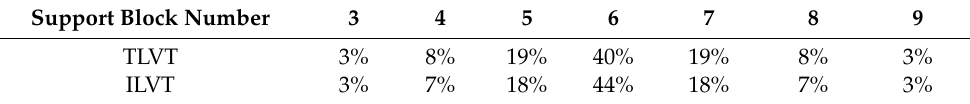
Table 3. Law of longitudinal sharing of transverse load.